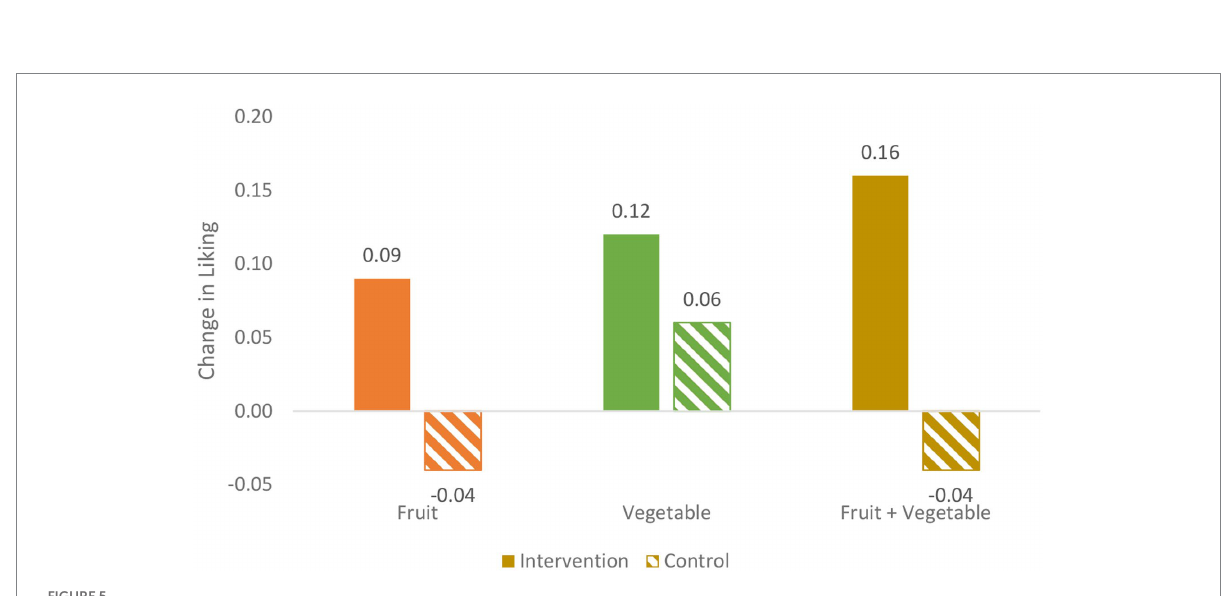
FIGURE 5 Pre-post change for intervention v. no intervention for F, V, and FV liking (ratings 1-5 of 6 F, 6